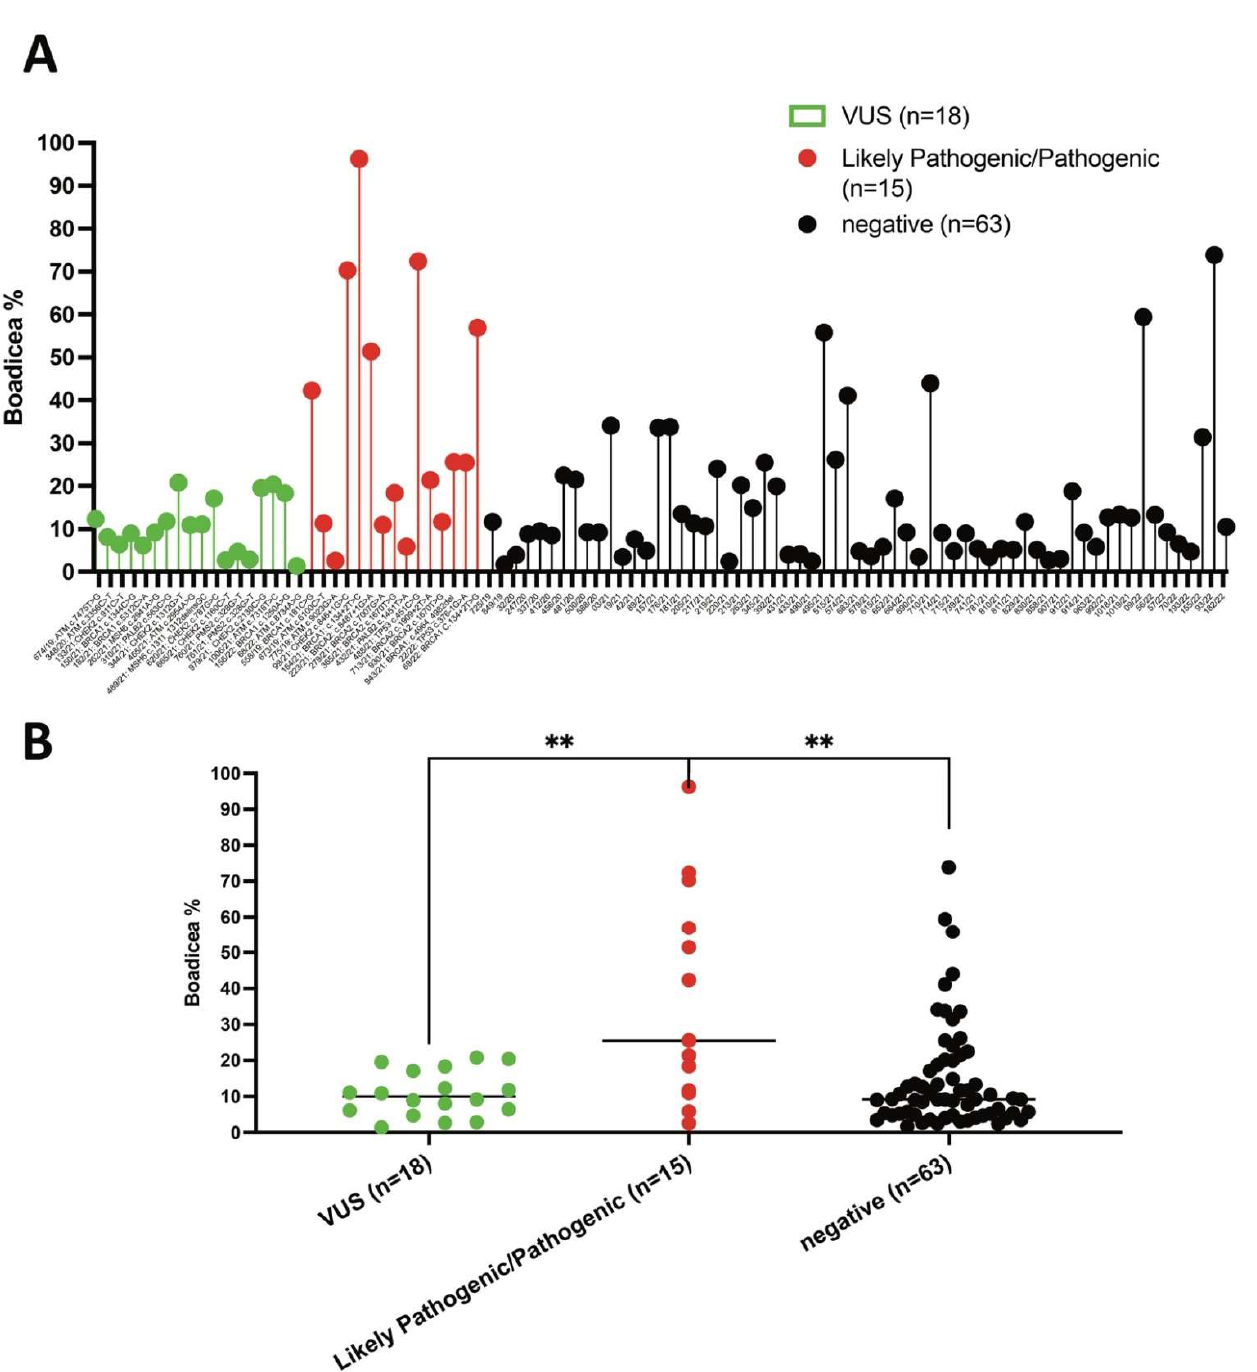
Figure 7. BOADICEA scores in LP/P variant-positive HBOC and prostate cancer patients versus negative and patients carrying VUS. ( A ) Distribution of total % BOADICEA score (likelihood of carrying PVs, sum of BRCA1 , BRCA2 , PALB2, CHEK2, ATM , BARD1 , RAD51D, RAD51C and BRIP1 ) for each patient. ( B ) BOADICEA scores between groups of patients depending on variant status (VUS, LP/P and negative). Differences between groups were assessed by the Mann–Whitney test; ** p < 0.01.